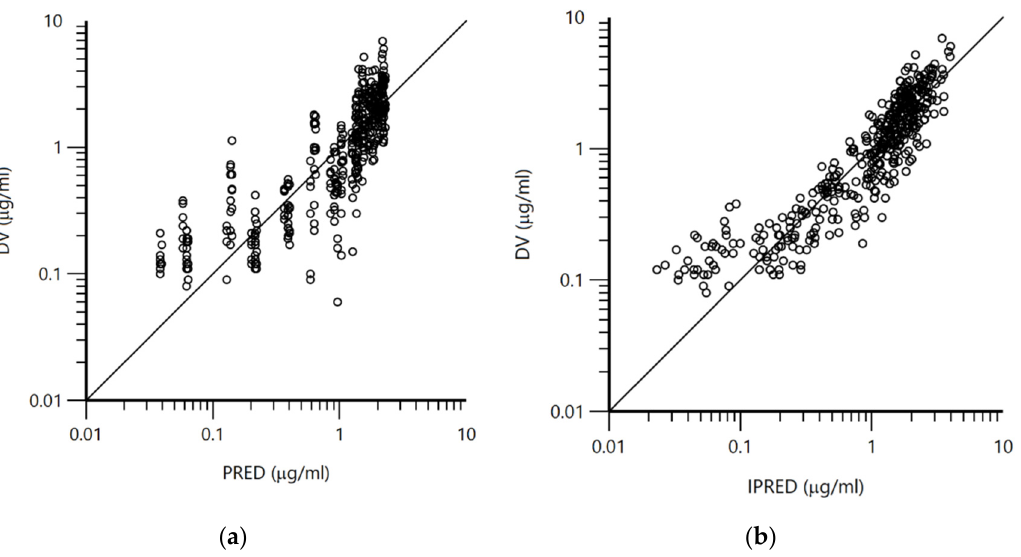
Figure 2. ( a ): Logarithmic plot of the dependent variable (DV, measured plasma concentrations in µg × mL − 1 ) versus predicted plasma concentrations (PRED, µg × mL − 1 ) of doxycycline in all treated chickens (n = 32). ( b ): Logarithmic plot of the dependent variable (DV, measured plasma concentrations in µg × mL − 1 ) versus individual predicted doxycycline concentrations (IPRED, µg × mL − 1 ) of doxycycline in all treated chickens (n = 32).